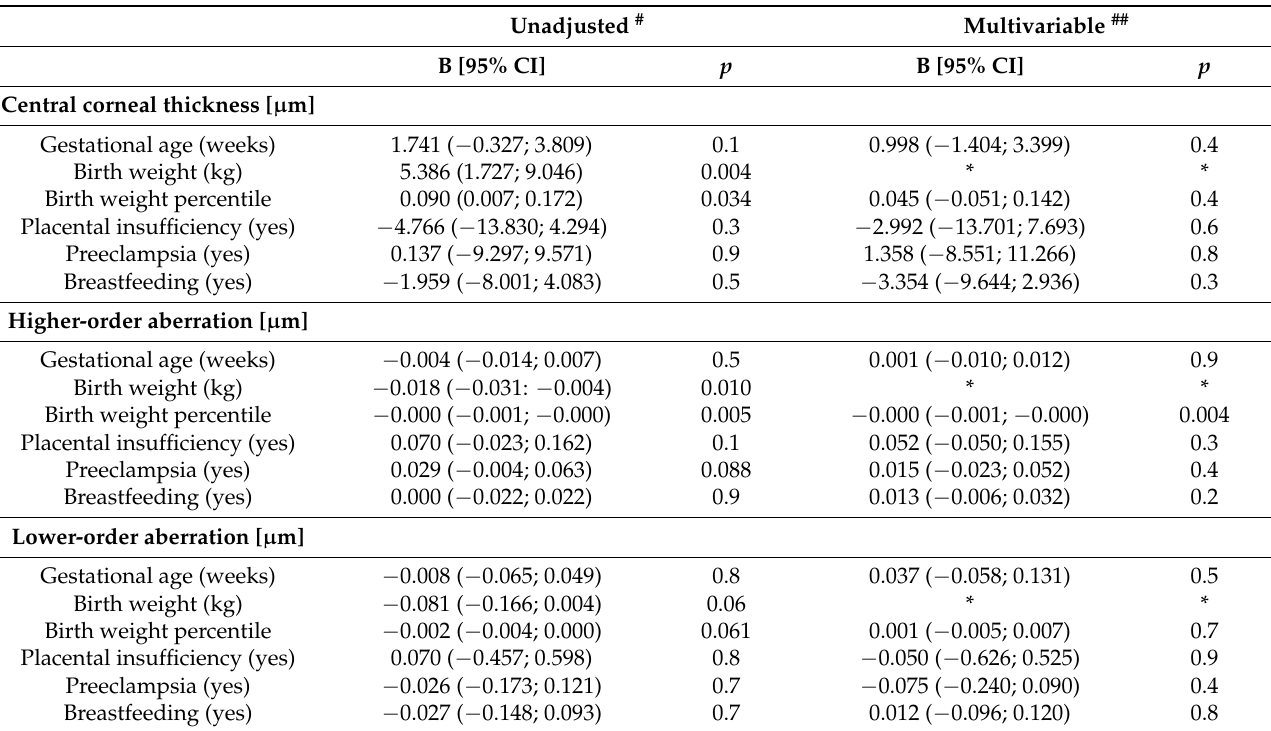
Table 5. Linear associations of total corneal aberrations with different perinatal parameters ( n = 261) of individuals born at term (37–43 gestational